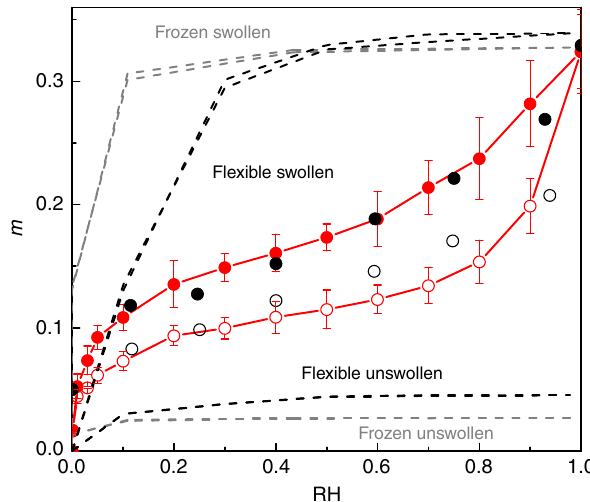
Fig. 2 Water adsorption and desorption in cellulose. Water sorption isotherms at T = 300 K in cellulose: (red circles) hybrid GCMC/MD molecular simulation, (black circles) sorption experiment from ref 9 . The experimental data were shifted up by m = + 0.05 to account for the presence of residual, i.e., non-desorbable water, in the dried material (see text). Open and closed symbols are adsorption and desorption data, respectively. The adsorbed amount is expressed as a moisture content m de fi ned as the mass of water per mass of dry material. The gray dashed lines correspond to the simulated, hysteresis-free sorption isotherms for water in the frozen unswollen and swollen cellulose material. The black dashed lines correspond to the same data but using simulations in which relaxation of the cellulose chains is allowed. The error bar is de fi ned as the standard deviation (s.d.) of the three